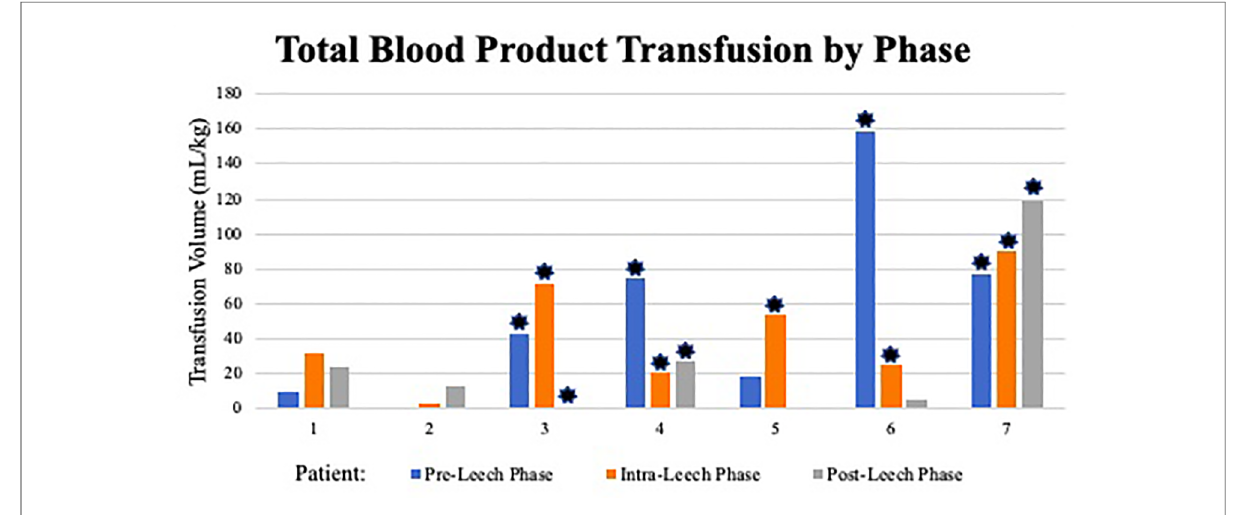
FIGURE 3 Total blood product transfusion by phase. ml, milliliter; kg, kilogram; *: indicates ECMO use within